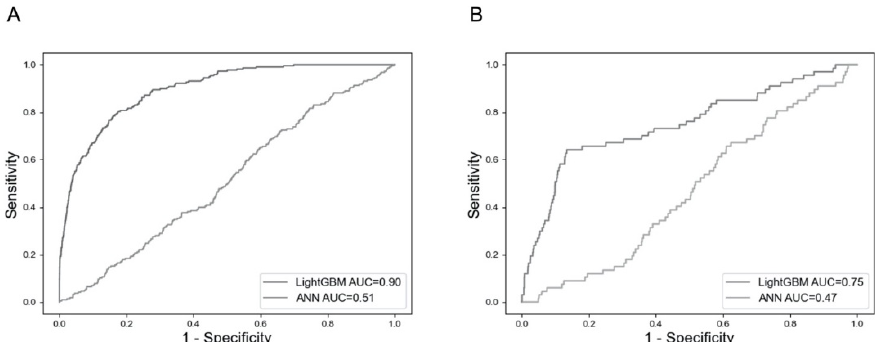
Figure 3. Comparison of receiver operating characteristics for the prediction of clinical refractures. ( A ) Evaluations in the training dataset. ( B ) Evaluations in the test dataset. ANN: artificial neural network; AUC: area under the curve.